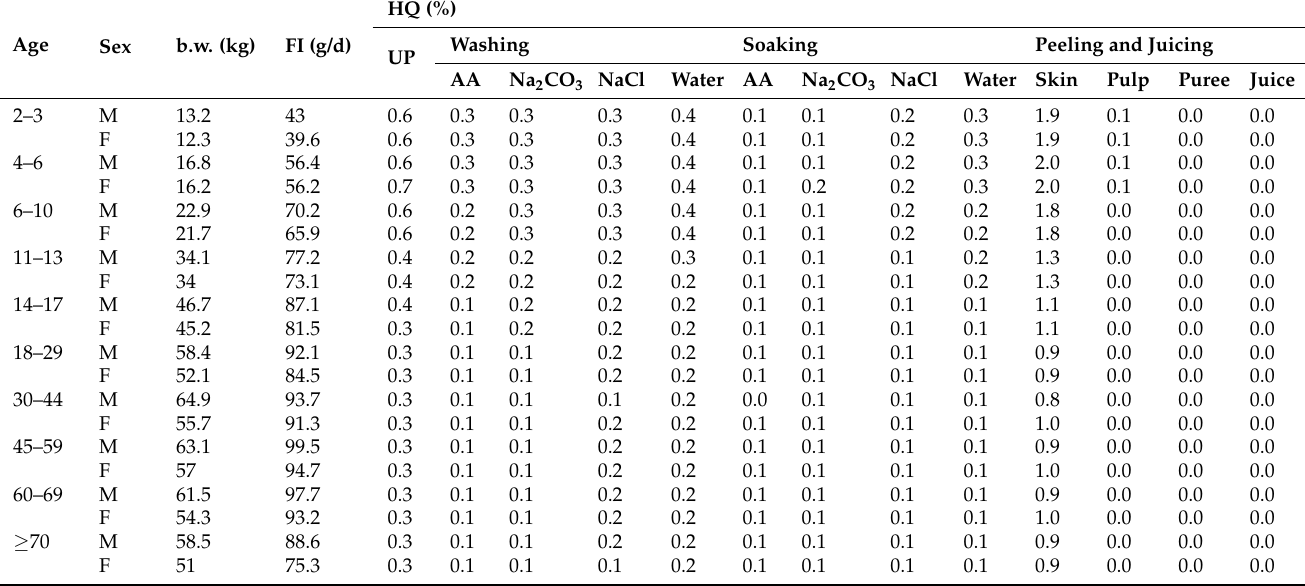
Table 6. Hazard quotient (HQ) of rac -mandipropamid in unprocessed (UP) and processing tomato samples for different groups of Chinese